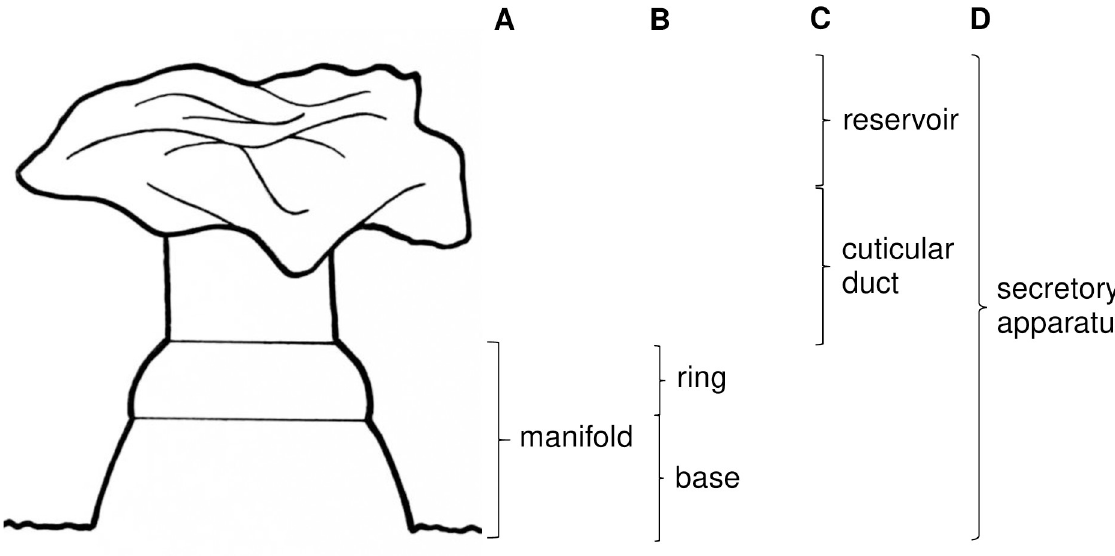
Fig 2. Drawing of the components of the secretory apparatus of Lu . longipalpis from Campo Grande, Brazil. A) manifold connected to the inner surface of the abdominal cuticle; B) components of the manifold, ring + base; C) secretory reservoir + cuticular duct; D) secretory apparatus; reservoir + cuticular duct +